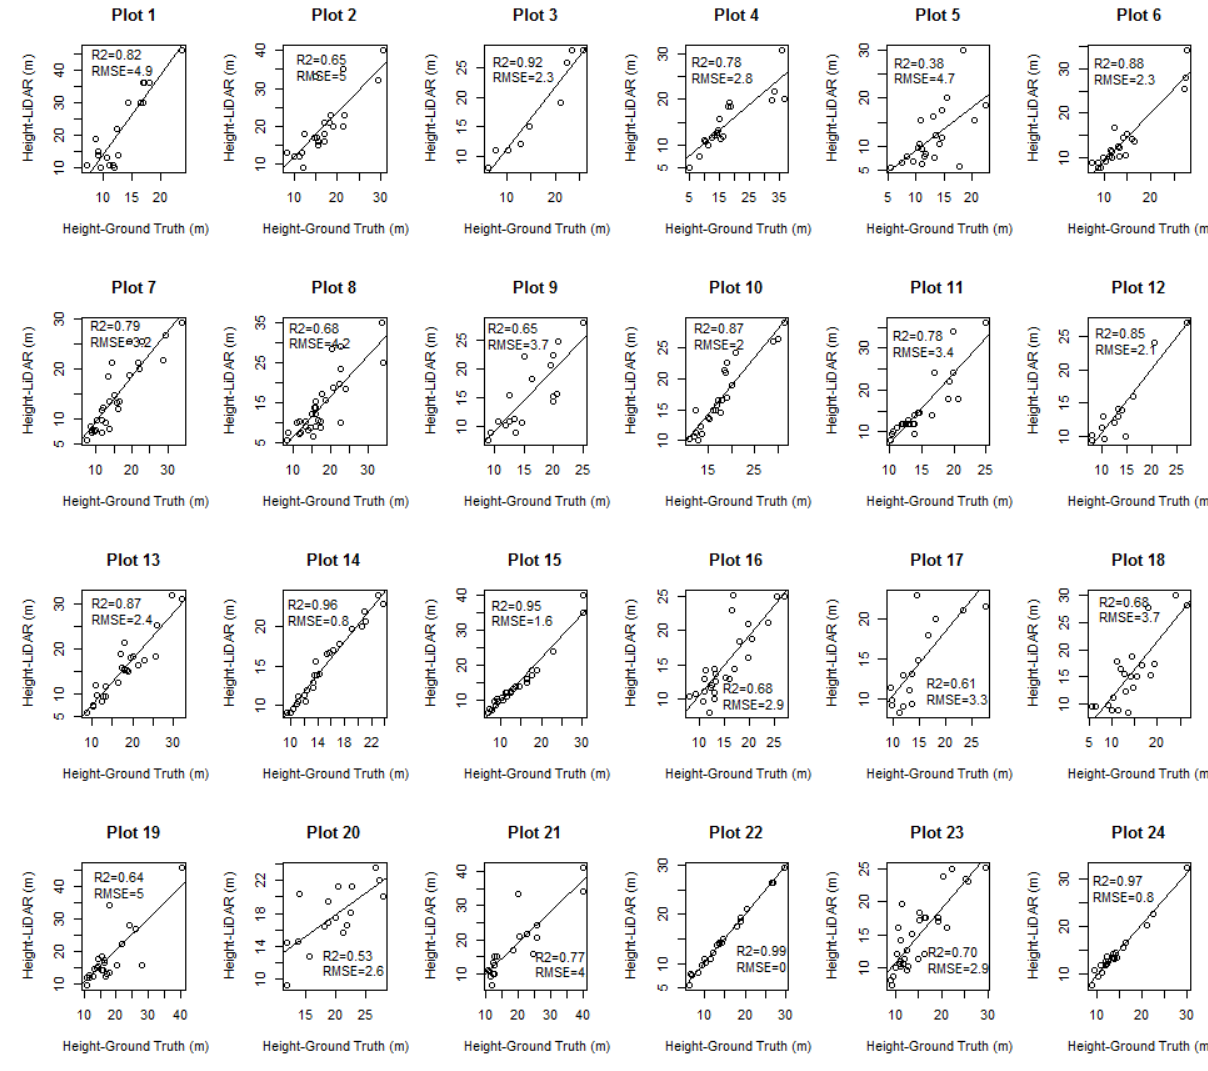
Figure 11. Plot level comparison between tree heights from field and T-LiDAR